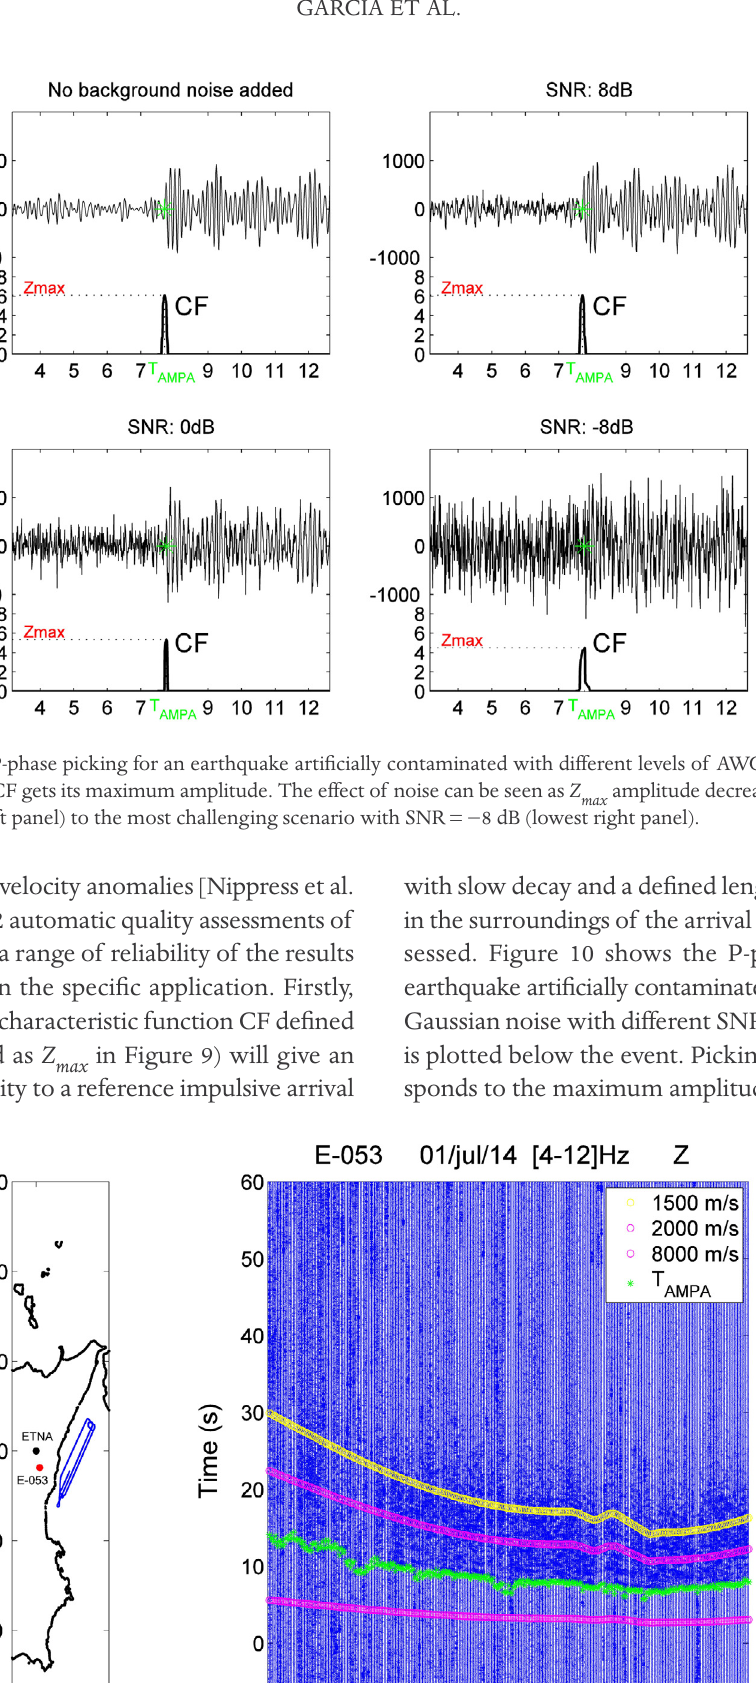
Figure 11. P-phase picking for shots produced on July 1st, 2014, as registered by the cube-station E-53. Arrival time (green dots), maximum and minimum arrival times at theoretical maximum and minimum speeds of 8000 m/s and 2000 m/s (pink line) and arrival of the water wave (yellow